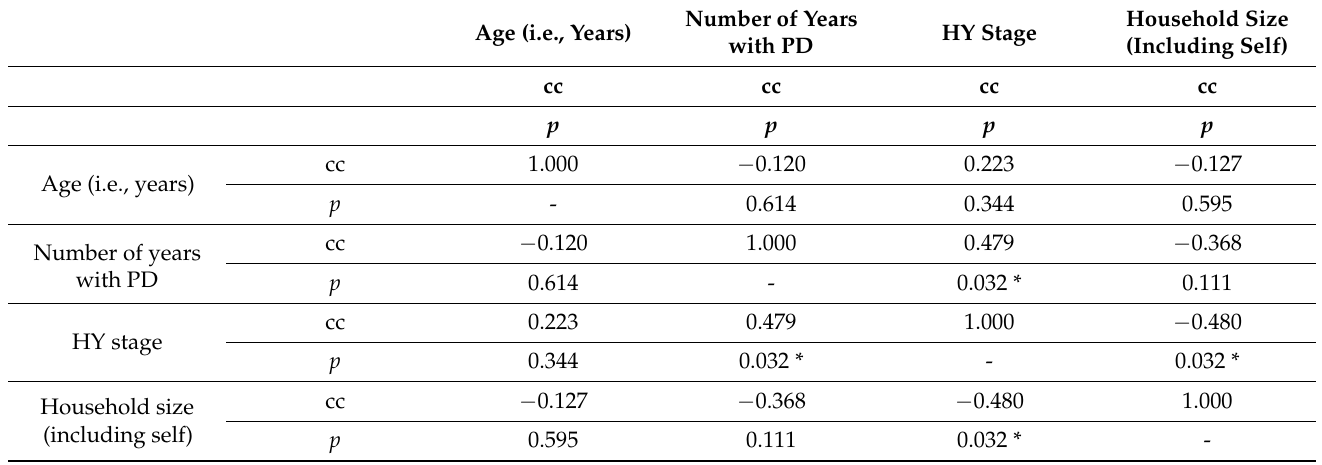
Table 2. Correlations between 4 patient